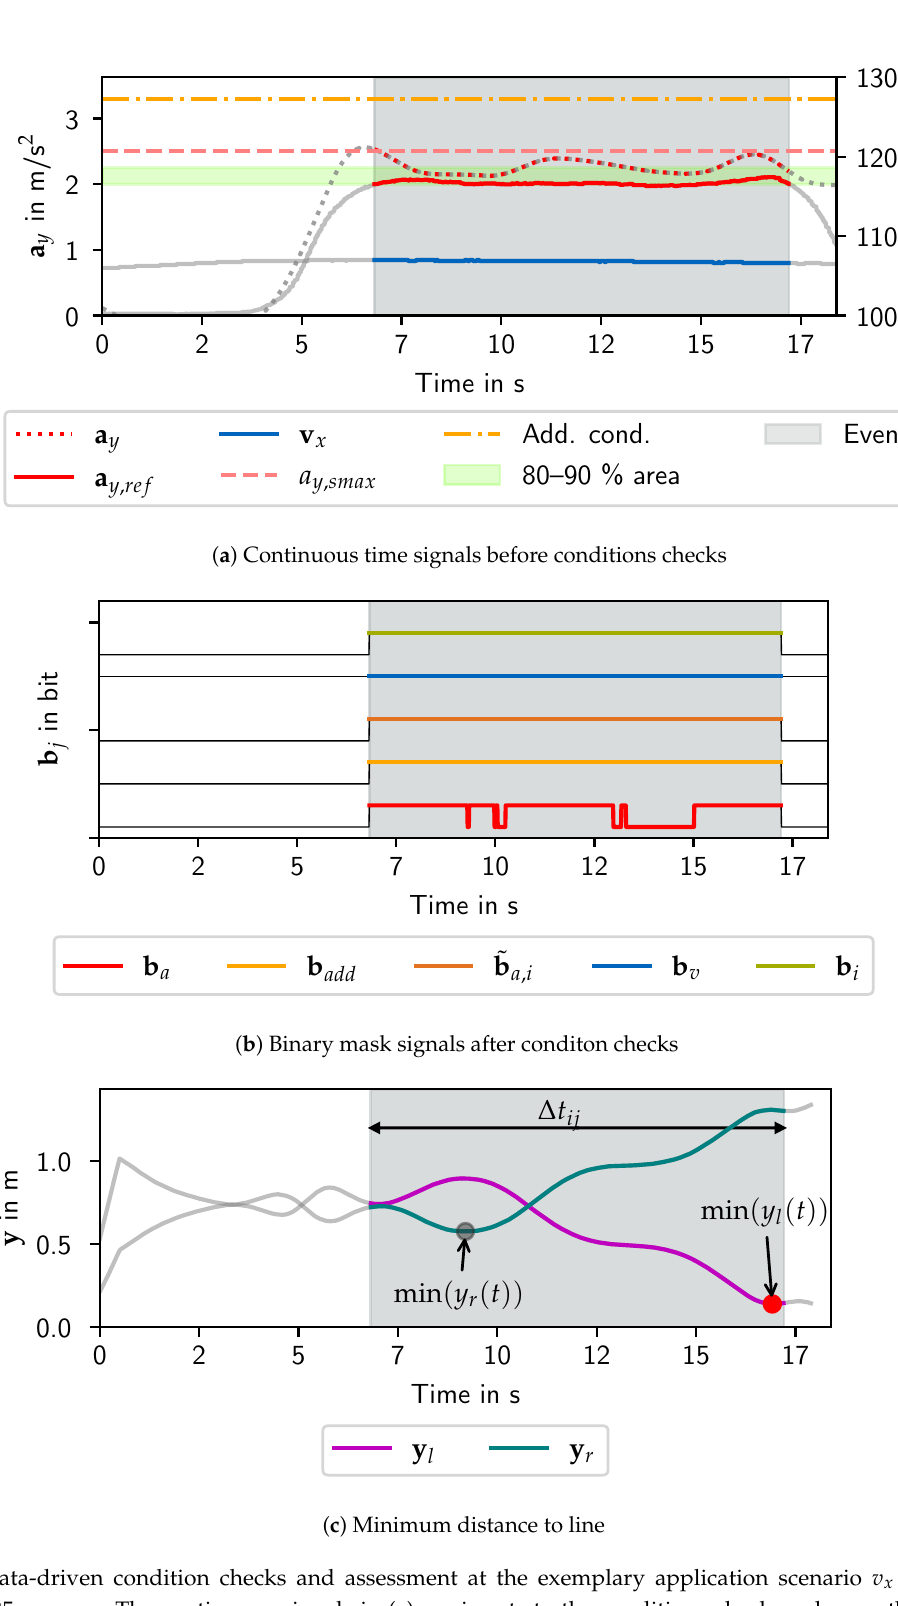
Figure 3. Data-driven condition checks and assessment at the exemplary application scenario v x = 107km/h and a y , ref = 0.85 a y , smax . The continuous signals in ( a ) are inputs to the conditions checks, whereas the binary signals in ( b ) are its outputs. The signals shown in ( c ) refer to the distance of the vehicle edges to the left and right lane markings and their minimum value over time. For decision making, we only consider the global minimum highlighted in red.